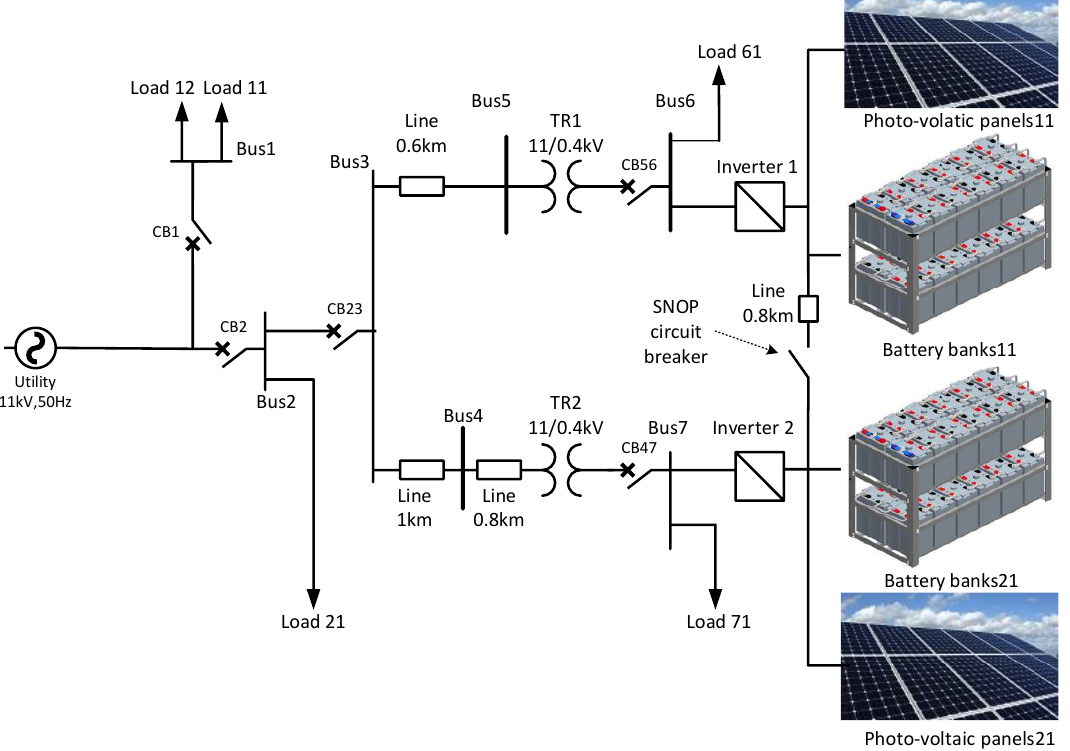
Figure 3. Model representation of low-voltage distribution grid.